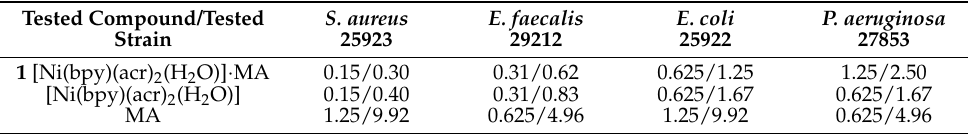
Table 4. The MBEC values [(mg/mL)/mM)] of the tested compounds. Tested Compound/Tested Strain